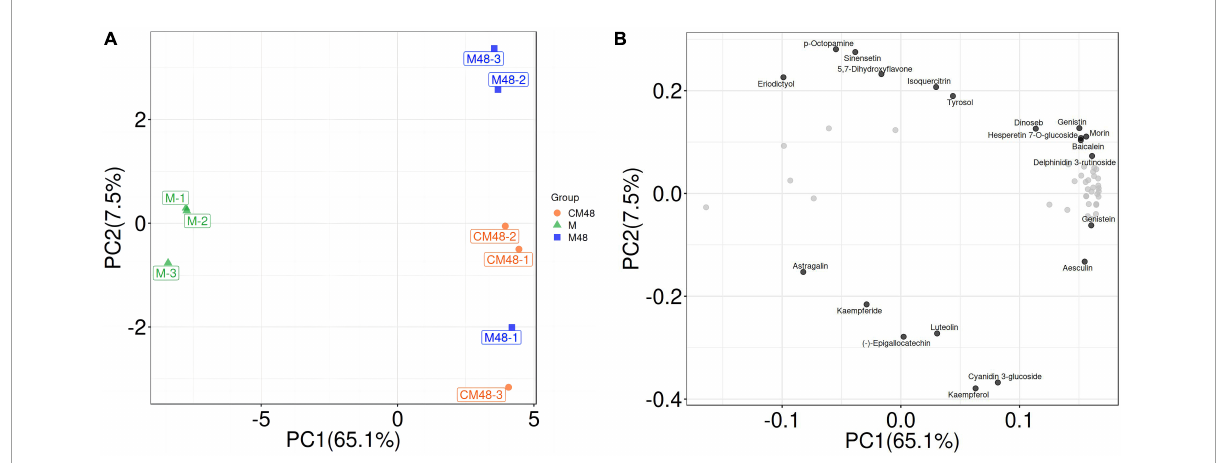
FIGURE5 Untargeted metabolomics PCA score plot (A) and PCA-Loading plot (B) . M, ungerminated mung bean; CM48, mung bean germinated for 48 h; M48, mung bean pretreated with a combination of ultrasonic and γ -aminobutyric acid (GABA) and germinated for 48 h.